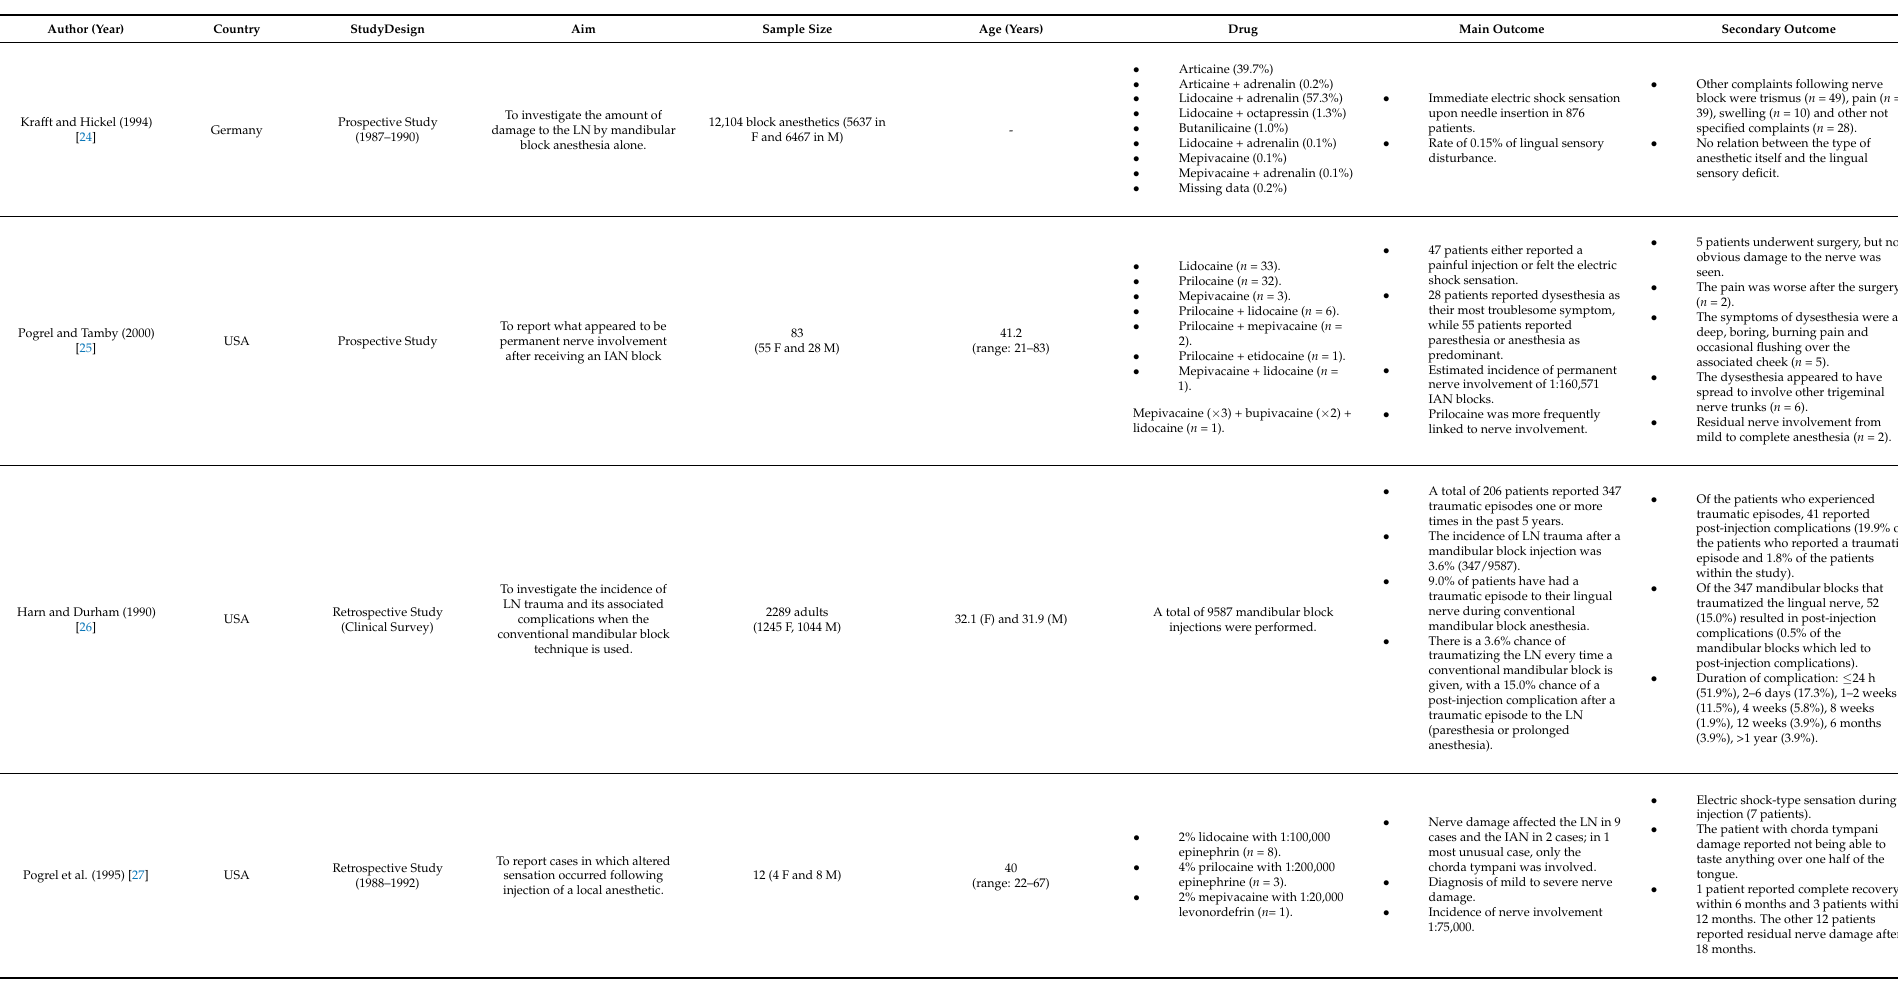
Table 1. Summary of the studies included in the review (list of abbreviations: LN = lingual nerve; IAN = inferior alveolar nerve; ADR = adverse drug reaction; NSD = neurosensory disturbance; EGM = electrogustometry; FPD = filter paper disk; F = female; M =